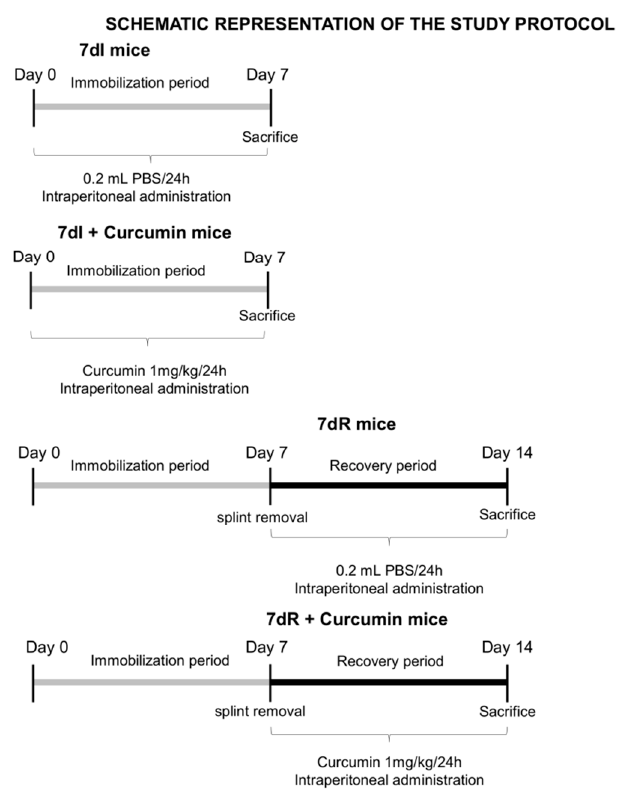
Figure 1. Schematic representation of the study protocol and groups of animals as well as of the different therapeutic approaches.